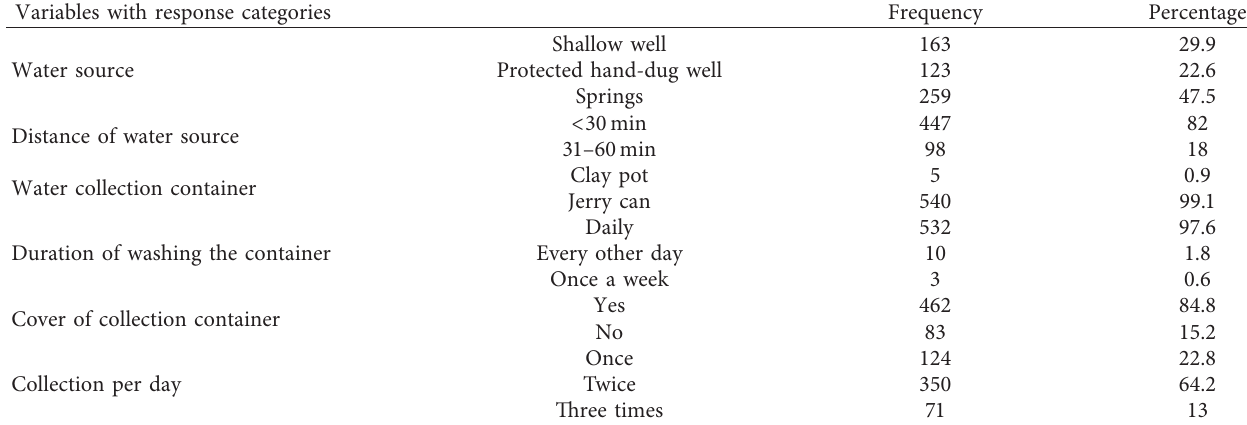
Table 2: Water sources and handling practice in Boloso Sore woreda, Wolaita zone, Ethiopia, January 2019 ( n � 545). Variables with response categories